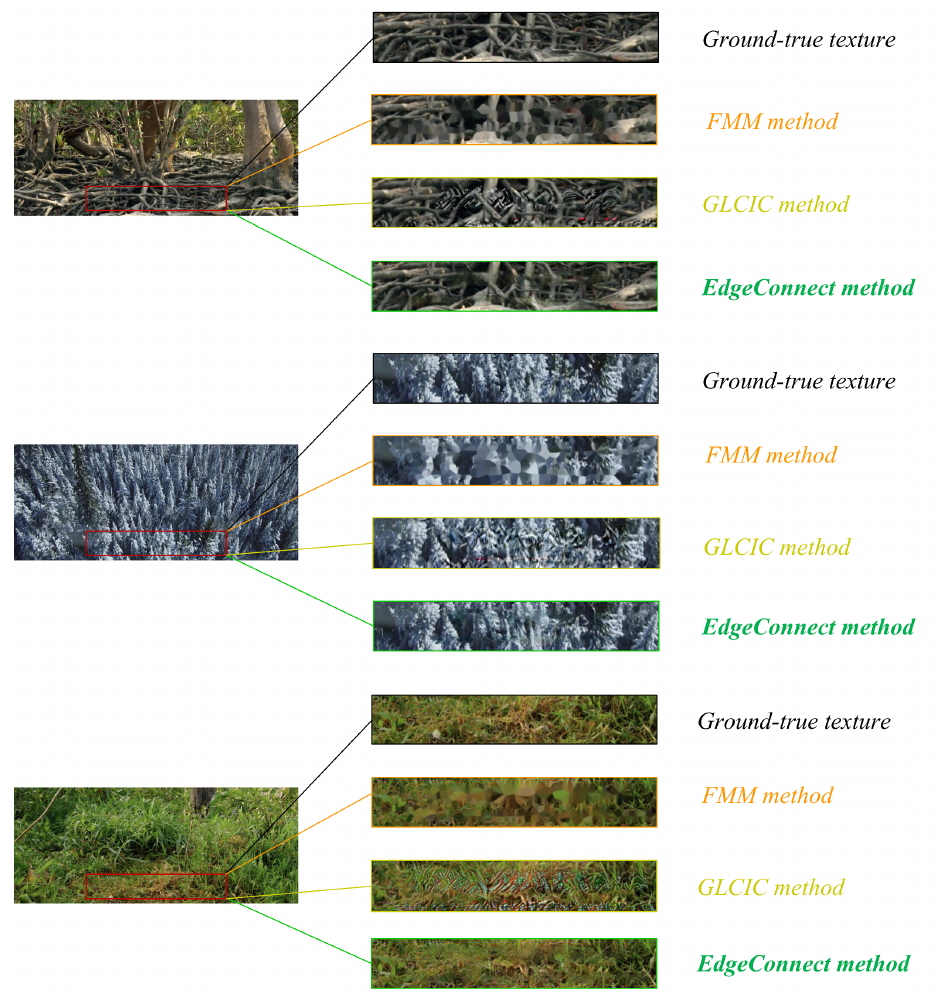
Figure 7. Zoomed-in comparison of the local texture details between the original frames and the inpainting results of other existing methods as well as our